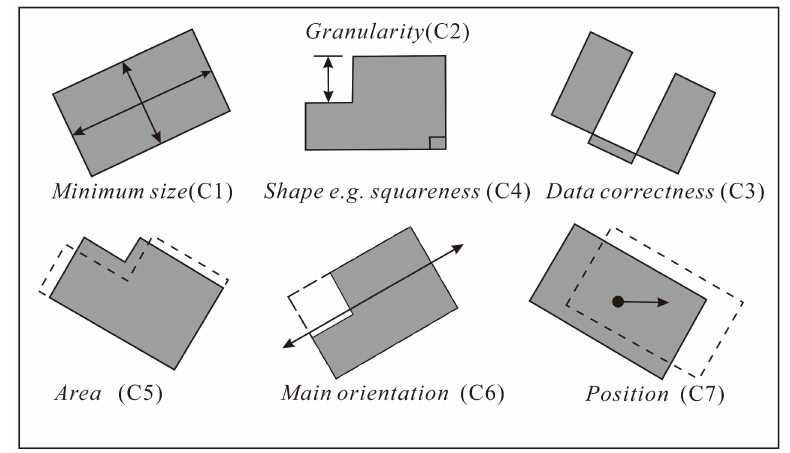
Figure 1. Constraints for building